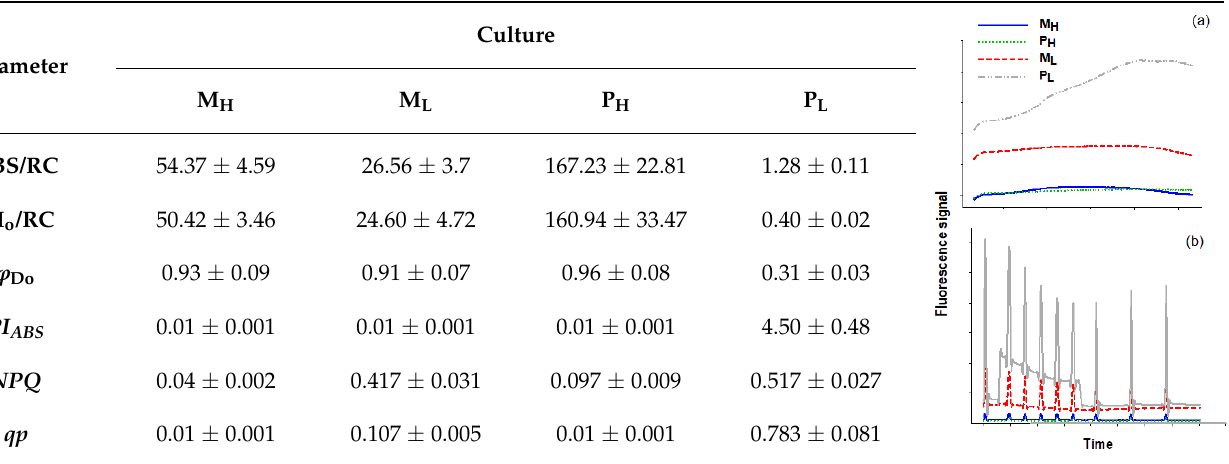
Figure 5. Maximum quantum yields of primary photochemistry (F v /F m ) of A. protothecoides culti- vated under the different conditions (each circle represents a different cultivation treatment; M H and M L stand for mixotrophy with high and low peptone, respectively, and P H and P L stand for photoautotrophy with high and low peptone, respectively). Table 1. Selected calculated parameters of the OJIP and non-photochemical quenching (NPQ) tests of A. protothecoides cultivated under white light. Inset figures: OJIP ( a ) and NPQ ( b ) signals of the associated cultures. Data represent the average ± SD of three replicates (n = 3). (M H and M L stand for mixotrophy with high and low peptone, respectively, and P H and P L stand for photoautotrophy with high and low peptone, respectively).